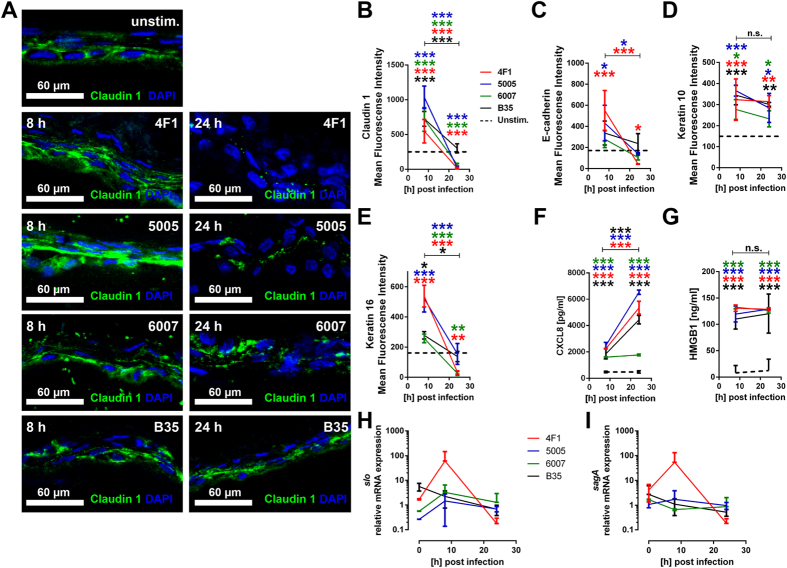
The impact of SDSE infection on epidermal tissue integrity and inflammation.(A) Representative immuno-staining of Claudin-1 and MFI (B–E) analysis of protein expression patterns of indicated proteins during the infection compared to the uninfected control (dashed line). Detection of CXCL8 (F) and HMGB1 (G) levels in model culture supernatants. (H–I) Relative mRNA expression of genes encoding for streptococcal virulence factors before (stationary phase cultures, t0) and during the infection in model tissue. Relative expression of slo and sagA before and during the infection are shown. The data represent the mean values ± SD (n ≥ 3). The statistical significance was determined using Kruskal-Wallis with Dunn´s multiple comparison test. (*p < 0.05; **p < 0.01; ***p < 0.001).